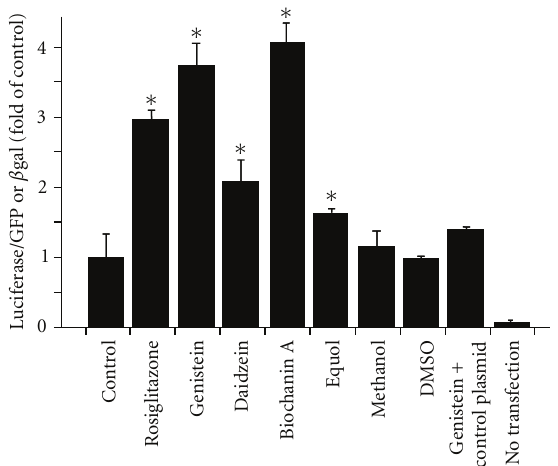
Figure 3: Isoflavones activate the PPAR γ promoter: cultured endothelial cells were transfected with plasmids containing the promoter response elements for PPAR γ (PPRE) or PPRE-negative plasmids and then exposed to indicated isoflavones (1 μ M) and vehicle controls. Data are expressed as fold of the control (i.e., relative to no isoflavone-treated cells) and are means ± SEM ( n = 3–6). ∗ Di ff erent from control, P ≤ . 005. They illustrate the ability of isoflavones to stimulate transcription of PPAR γ -regulated genes. Genistein, daidzein, and biochanin A (4 (cid:2) -methoxygenistein) have promoter activities comparable to rosiglitazone (figure reproduced with permission by the Journal of Nutrition